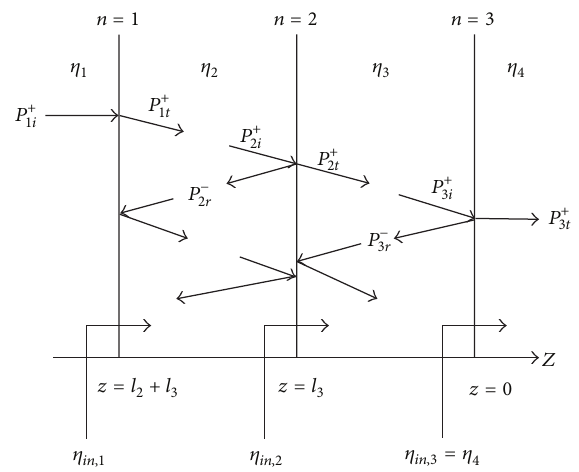
Figure 5: Planar impedance transformation model for a three-inter- face, four-layer case.